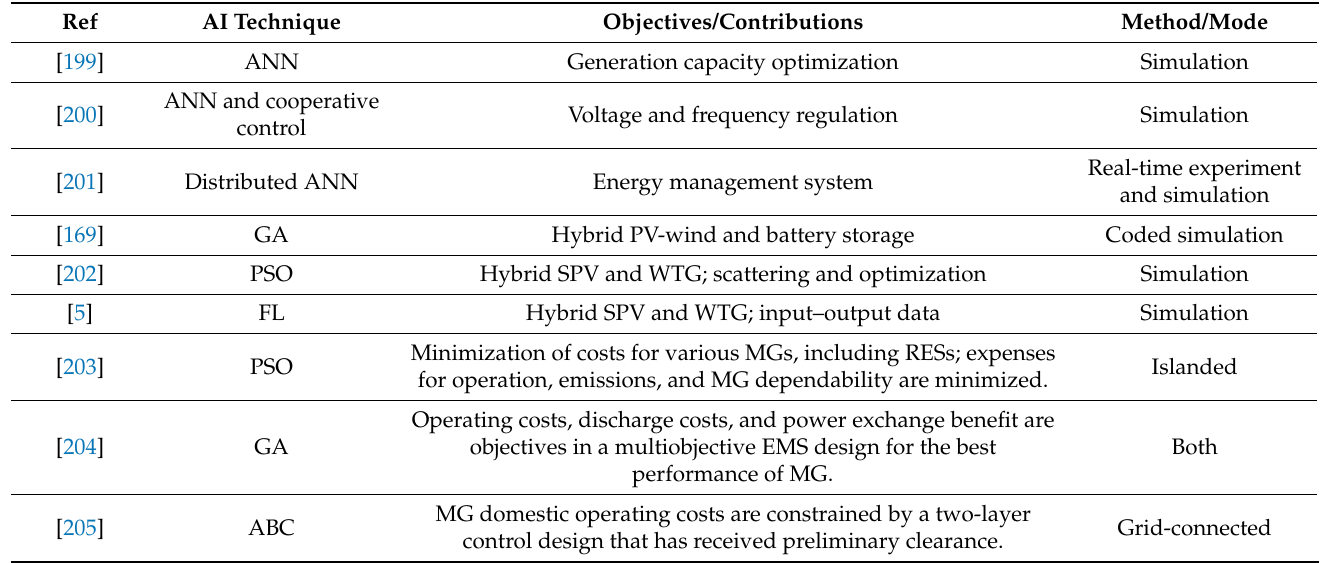
Table 3. Summary of different optimization AI techniques used in